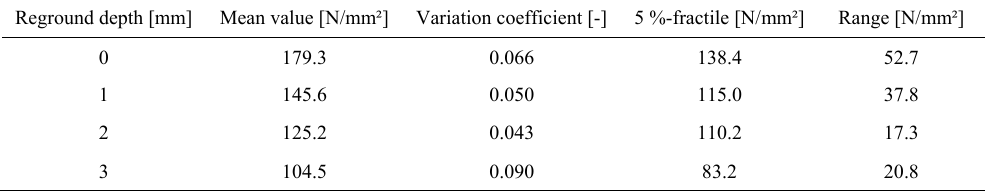
Table 5: Statistical evaluation HS specimens